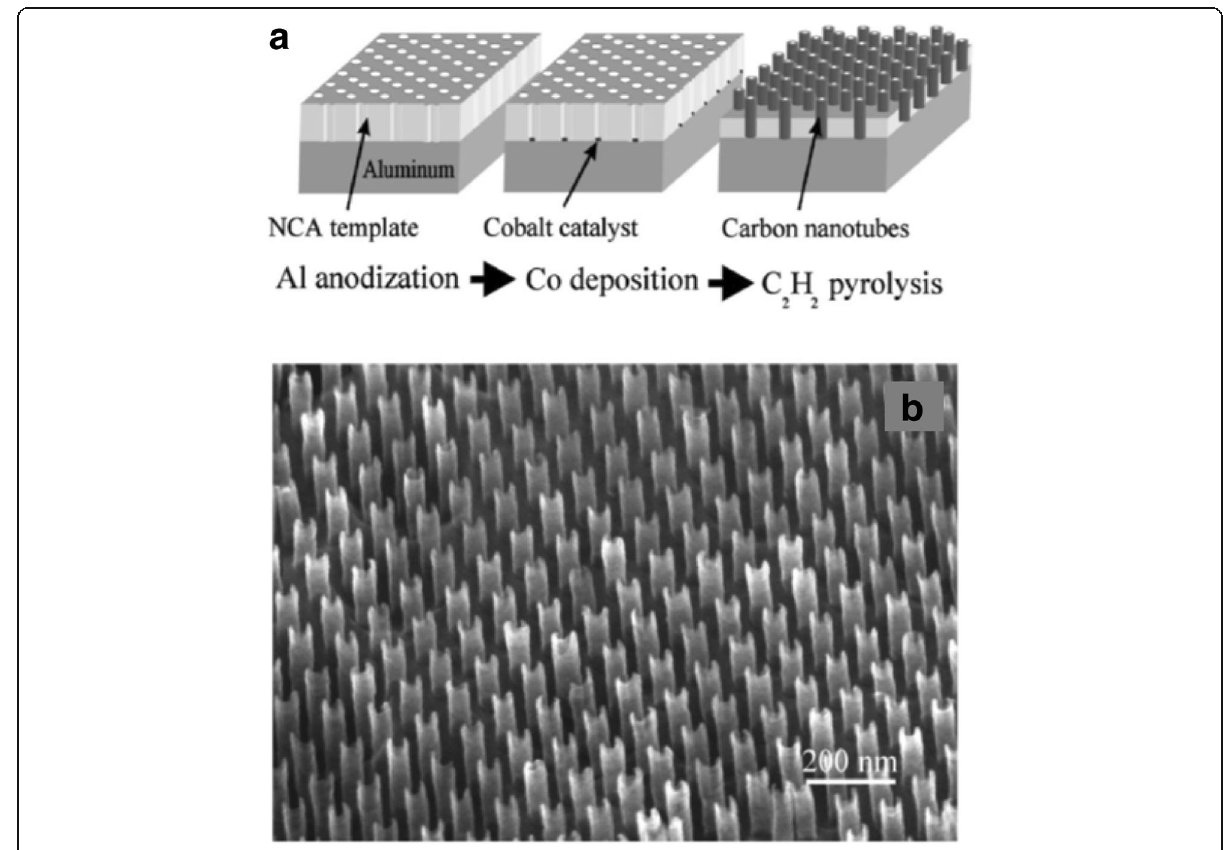
Fig. 32 a Mechanism of growth of highly-ordered arrays of parallel CNTs using nanochannel anodic alumina templates. The process begins with the anodization of high-purity aluminum on the substrate. By varying the anodization conditions, hexagonal close-packed arrays of varying diameters, densities and lengths can be formed. Adapted from [227]. b SEM image of the resulting hexagonally ordered array of CNTs fabricated using the method in ( a ). Adapted from